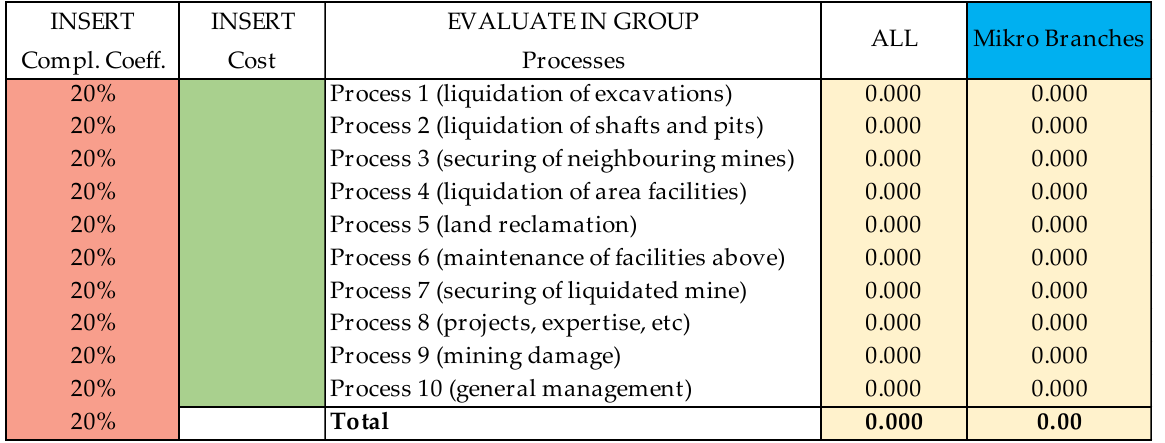
Figure 4. Screenshot of the liquidation costs assessment tool.